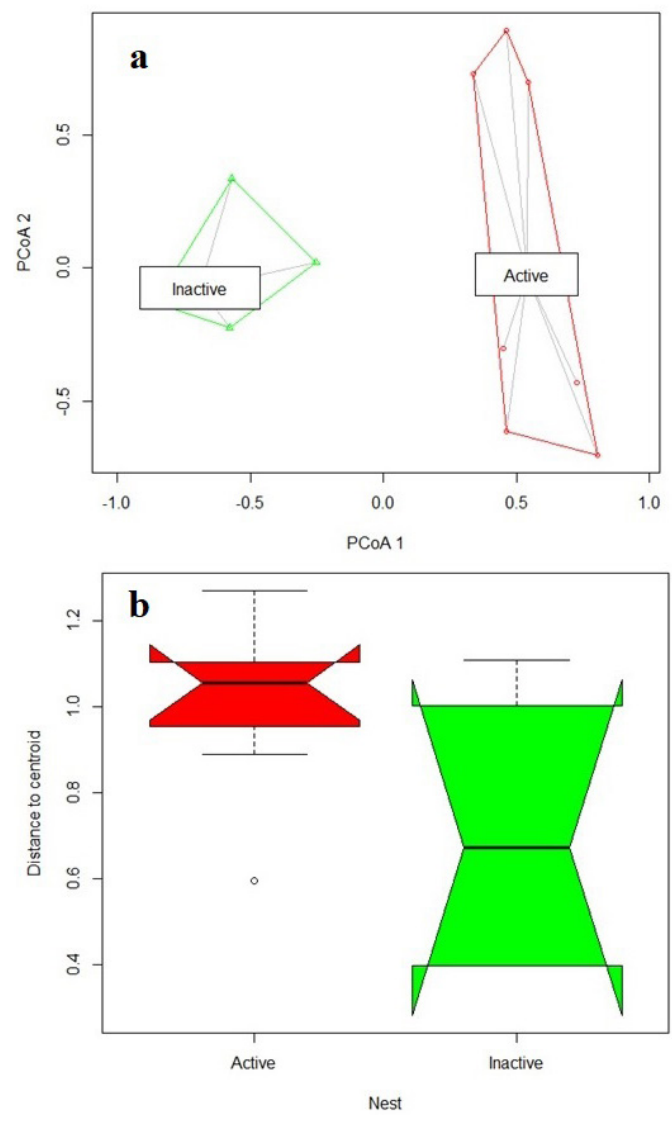
PLANTS SURROUNDING PETREL NESTS